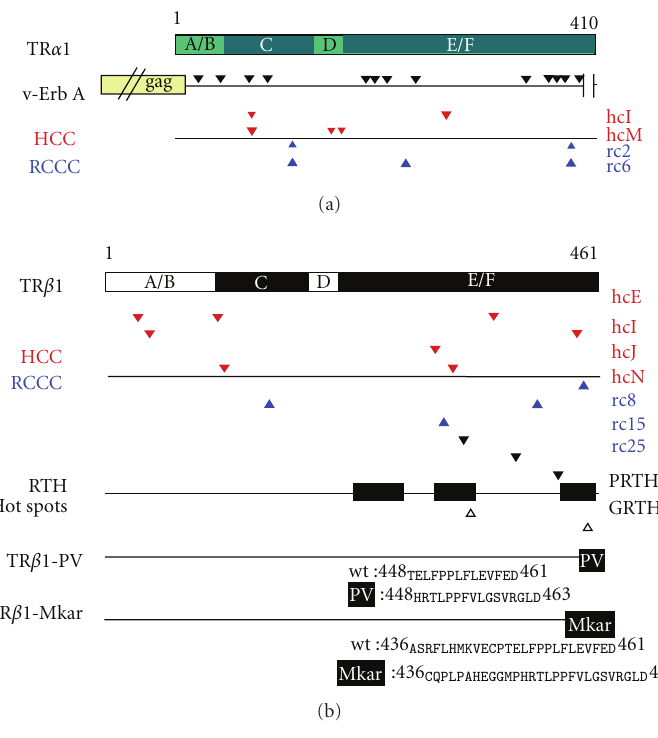
Figure 4: Oncogenic- and RTH-associated mutations in di ff erent TR isoforms. (a) A schematic of wild-type TR α 1 is shown as a horizontal bar as in Figure 1; beneath, horizontal lines depict v-Erb A and several representative HCC/RCCC TR α 1 mutants. As a result of fusion of retroviral gag-sequences, the N-terminus of v-erb A is 12 amino acids shorter than TR α 1. V-erb A’s 13 mutations are indicated by black arrowheads. From left to right, they are R24H, Y44C, G73S, K90T, K186R, P191L, P203L, K233N, T342S, P363S, T370A, C378Y, and F395S. A 9 amino-acid C-terminal deletion is indicated by vertical lines. All mutations and deletions are in relation to the avian TR α 1 sequence [24]. Under the schematic for v-Erb A, red and blue arrowheads indicate mutations found in representative HCC and RCCC mutants, respectively, [37–39]. The nomenclature for each mutant is provided at the far right of the figure. For HCC, these mutants are hcI-TR α 1 (K74E, A264V) and hcM-TR α 1 (K74R, M150T, and E159K). For RCCC, these mutants are rc2-TR α 1 (I116N and M388I) and rc6-TR α 1 (I116N, A225T, and M388I). (b) A schematic of wild-type TR β 1 is shown as a horizontal bar as in Figure 1; beneath, horizontal lines depict several representative HCC/RCCC TR β mutants, RTH hot spots, and the RTH mutant, TR β 1-PV. As above, red and blue arrowheads indicate representative mutations found in HCC and RCCC [37–39]. For HCC, these mutants are hcE-TR β 1 (M32I, C107R, and T368N), hcI-TR β 1 (S43L, C446R), hcJ-TR β 1 (M313I), and hcN-TR β 1 (K113N and T329P). For RCCC, these mutants are rc8-TR β 1 (F451S), rc15- TR β 1 (K155E, K411E), and rc25-TR β 1 (Y321H). Below the schematic for HCC/RCCC mutants, the locations of RTH hot spots are shown (amino acids 234–282, 310–353, and 429–460 [36]). Representative mutants for PRTH are: R338L, R383H, and R429Q. For GRTH, these mutations are G345S and P453S. The TR β 1-PV mutant has undergone a C-insertion at codon 448 that results in a frameshift at the C- terminus of the receptor [40]. The location of the 16 new PV-specific amino acids is indicated by a black box on the TR β 1-PV schematic, and the identities of these amino acids (and their wild-type TR β 1 counterparts) are shown below. The TR β 1-Mkar mutant has a T insertion at codon 436 that results in a frameshift at the C-terminus of the receptor. The locations of these new 28 amino acids are indicated by a black box on the TR β 1-Mkar schematic, and their identities are shown below. Note that Mkar shares with PV the amino acid sequence from codons 448 to 463